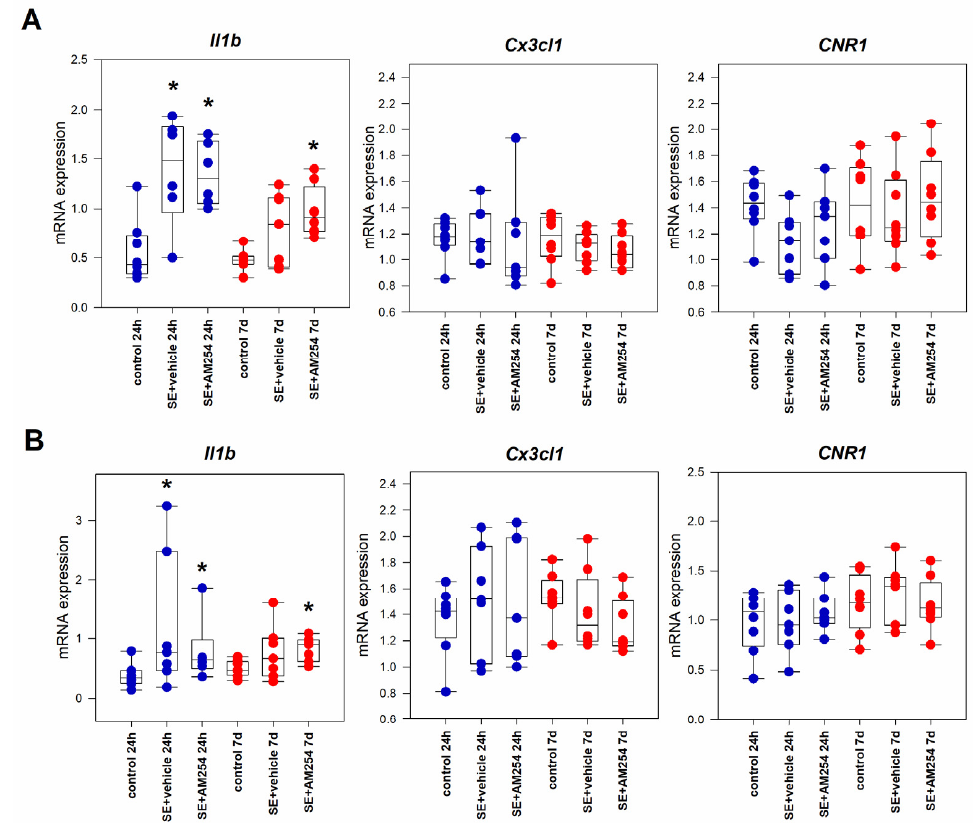
Figure 1. Il1b , Cx3cl1 , and CNR1 mRNA expression in the dorsal ( A ) and ventral ( B ) hippocampus 24 h and 7 days after SE in rats with no SE (control), vehicle-treated treated rats (SE + vehicle), and AM251-treated rats (SE + AM251). Data are represented as medians with interquartile ranges; dots represent individual values. * statistically significant differences at p < 0.05 in comparison with the corresponding control group, Kruskal–Wallis test.